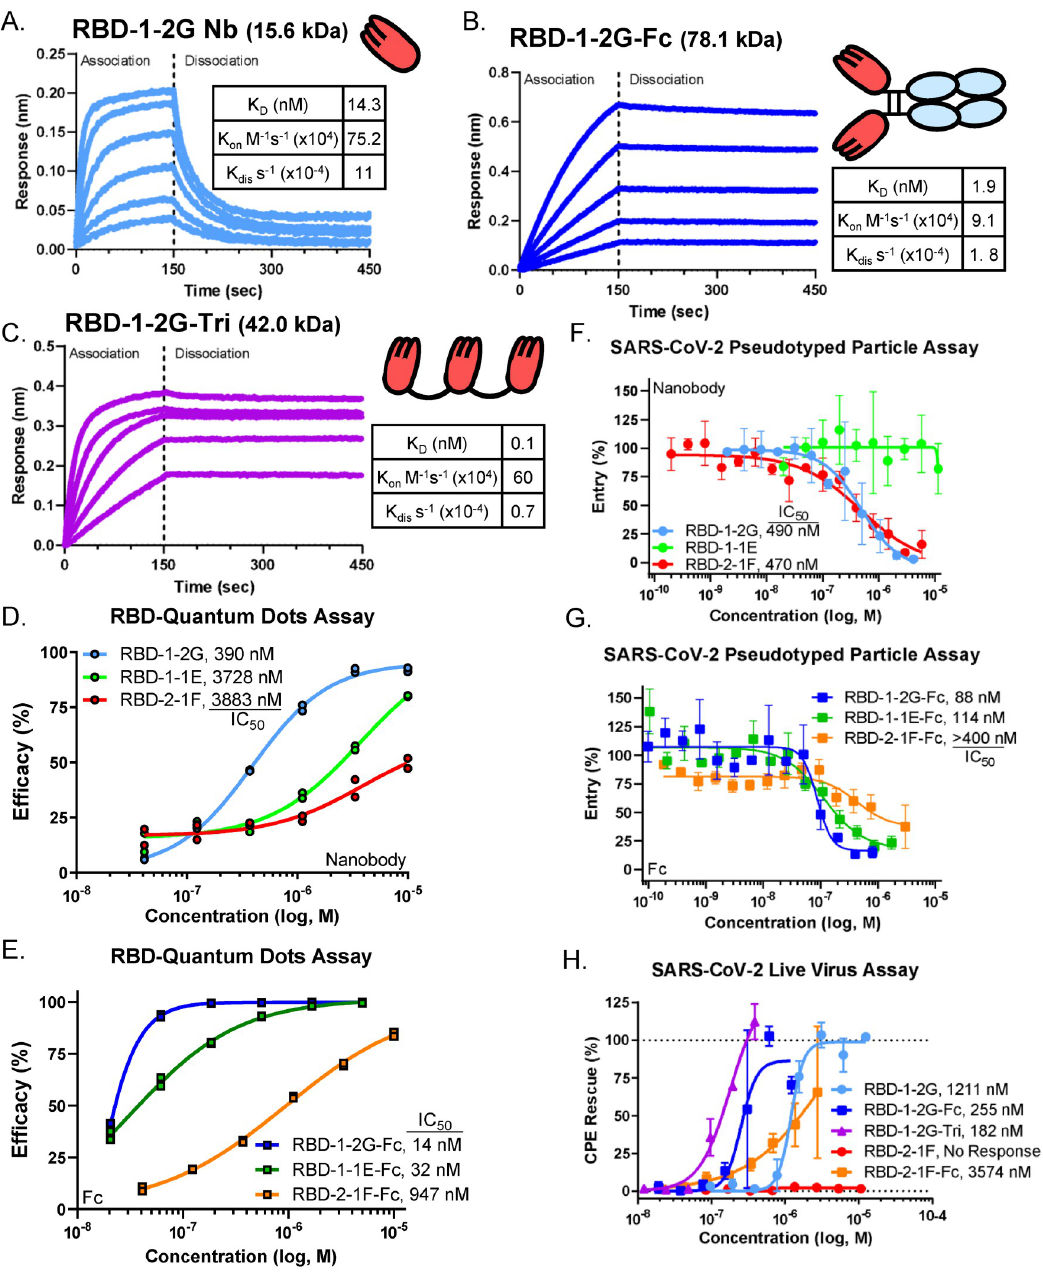
Fig 2. Multivalency improves affinity and inhibition of SARS-CoV-2 infection in vitro . (A-C) Bio-layer interferometry binding profiles for the (A) RBD-1-2G Nb, (B) RBD-1-2G-Fc and (C) RBD-1-2G-Trimer against RBD-His (100 nM to 6.25 nM, 1:2 dilution). (D-E) QD endocytosis assay using QD 608 -RBD and ACE2-GFP HEK293T cells to visualize receptor binding. Nanobody efficacy in reducing RBD internalization by (D) Nanobody and (E) Fc constructs. N = duplicate wells, approximately 2500 cells and 1600 cells, respectively. (F-G) SARS-CoV-2 pseudotyped particle entry assay using HEK293-ACE2 cells as target. Inhibition of pseudotyped particle entry was tested for Nanobody(F) and Fc(G) constructs Representative data from two independent experiments. Data represents mean inhibition per concentration (n = 3), all error bars represent SEM. Inhibition of SARS-CoV-2 live virus infection with the RBD-1-2G and RBD-2-1F in various formats. Representative biological replicate with n = 2. Technical replicates are n = 2 per concentration, all error bars represent